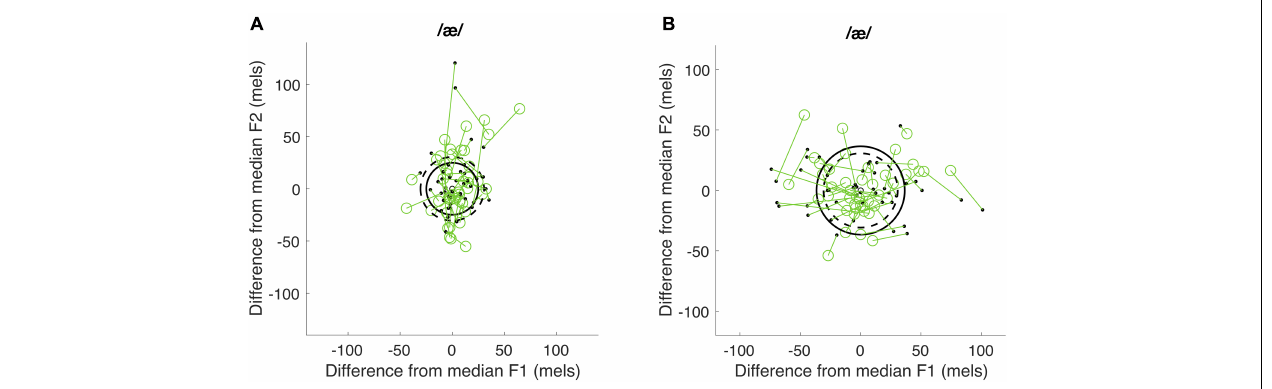
FIGURE 3 | Examples illustrating centering ratio. Panel (A) shows a positive centering ratio and panel (B) a negative centering ratio. The F1 and F2 values were plotted as the difference from the median F1 and F2 values for each time window. The green open circles represent the difference between the initial F1 and F2 values for each utterance and the values representing the median values for each formant. The black dots represents the difference between the midpoint F1 and F2 values for each token and the median midpoint F1 and F2 values. Dashed line represents the average initial distance to the median and solid line represents the average midpoint distance to the